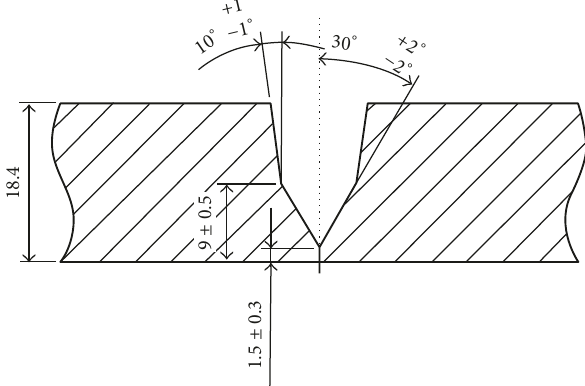
Figure 1: Schematic of the double-V groove (unit: